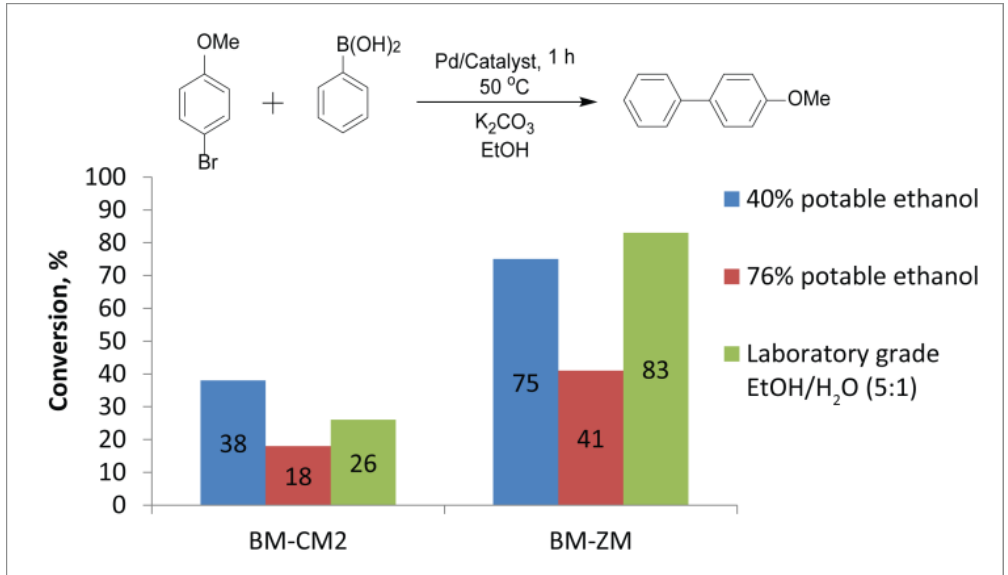
Figure 7. Comparison of average conversions from three experiments. Reaction of bromoanisole with phenylboronic acid in the presence of Pd/BM-CM2 and Pd/BM-ZM catalysts in different EtOH/H 2 O mixtures.